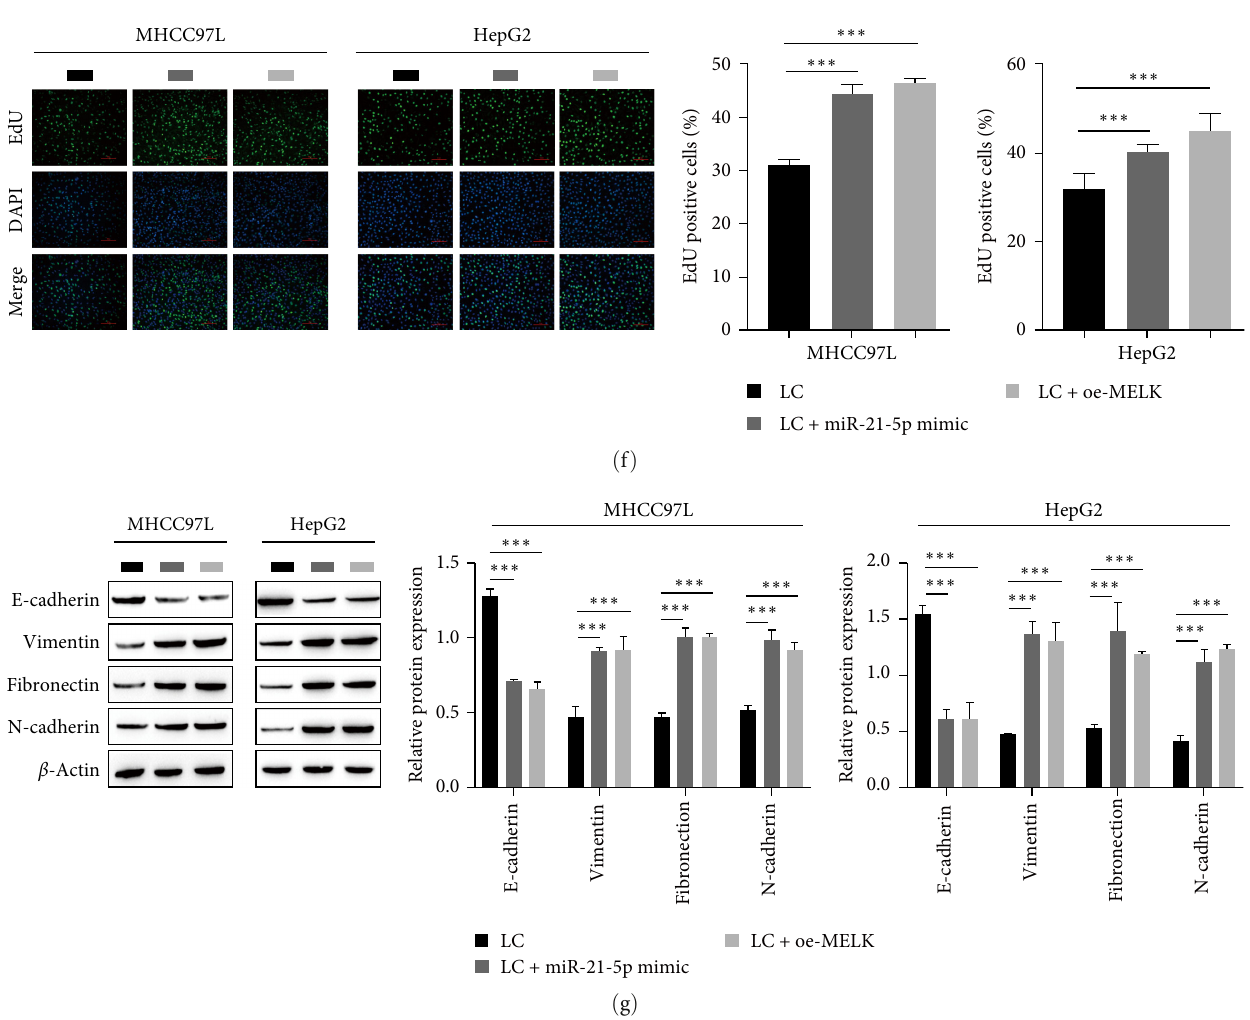
F IGURE 2: Overexpression of miR-21-5p and MELK can facilitate EMT in hepatocellular carcinoma cells: (a) transfection ef fi ciency of miR-21-5p mimic by RT-qPCR; (b) RT-qPCR for detecting transfection ef fi ciency of oe-MELK; (c) clone formation assay for cell proliferation; (d) cell viability by CCK8; (e) transwell assay for cell invasion and migration; (f) EdU staining for cell proliferation; (g) Western blot for the level of EMT-related proteins. ∗∗ P < 0 : 01, ∗∗∗ P < 0 :